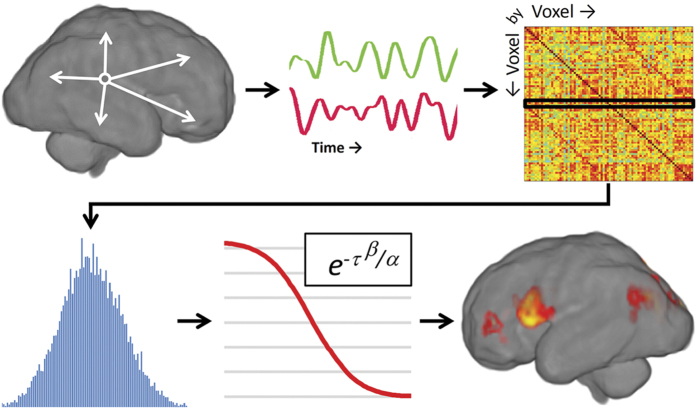
Overview of ICD analysis.For any voxel in the gray matter, the voxel’s time course is correlated with every other voxel’s time course. This procedure is repeated for every voxel, resulting in a voxel-by-voxel correlation matrix. From this matrix, a single row is extracted (representing all correlation to a voxel) and converted to a histogram to estimate the distribution of connectivity for that voxel. From this distribution, a survival function is constructed and parameterized with a stretch exponential with unknown parameters α and β. For our purposes, α controls the rate of decay of the survival function with a larger α indicating a slower decay and larger global connectivity. The α ICD maps can then be thresholded to reveal putative hubs of the fetal connectome.